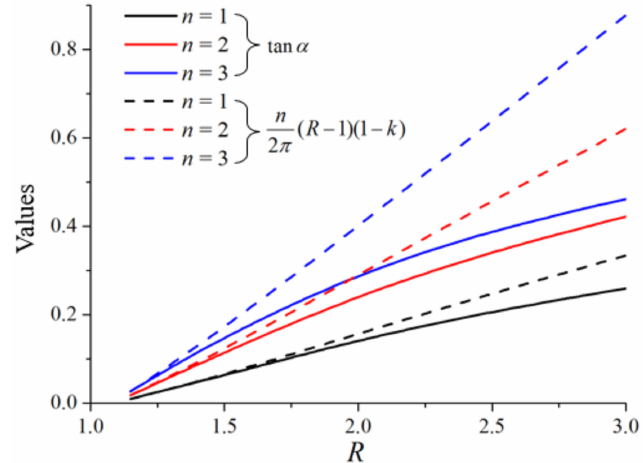
Figure 6. Theoretical comparison of the left- and right-hand sides of Equation